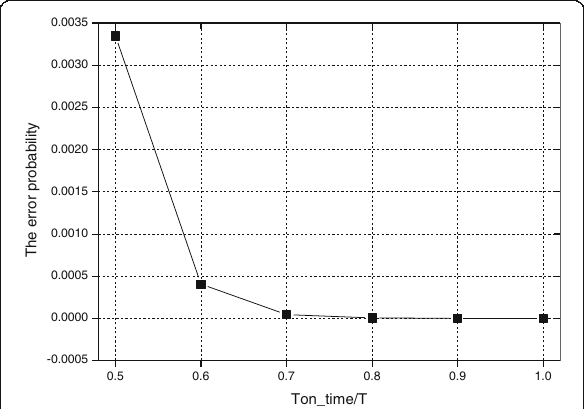
Fig. 3 The bit error rate under MQAM